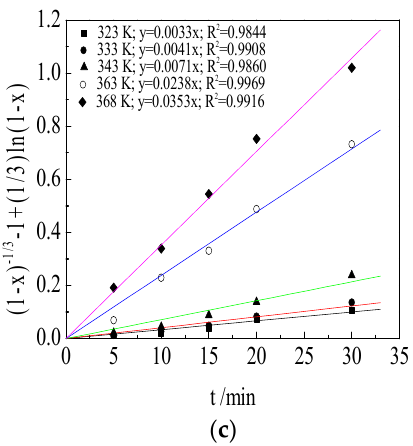
Figure 9. Plots of (1 − x ) 1/3 − 1 + (1/3)ln(1 − x ) versus time at different temperatures of leaching TMn ( a ); MnO 2 ( b ); and MnCO 3 ( c ) in semi-oxidized manganese ore.